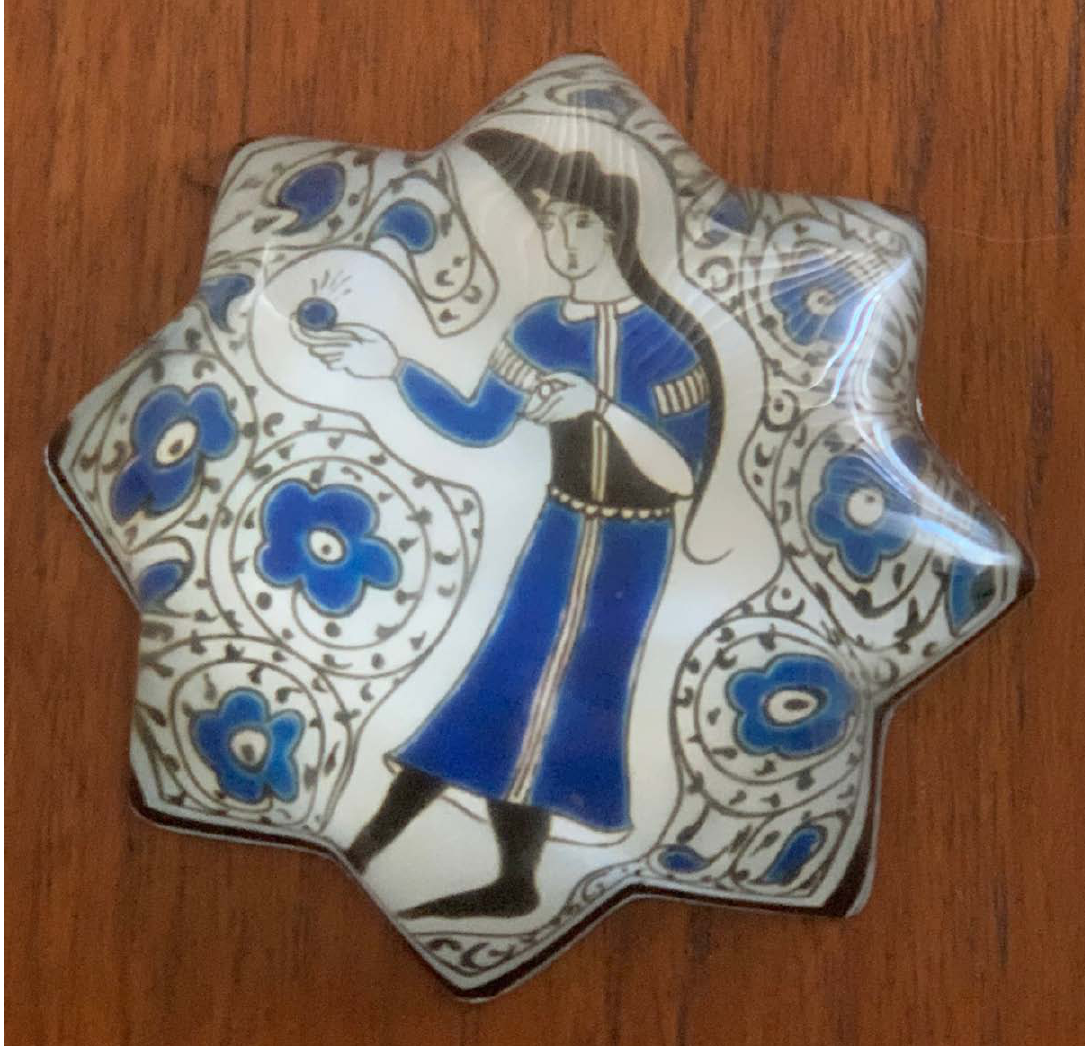
Figure 1. Souvenir paperweight from Turkey; © Vera